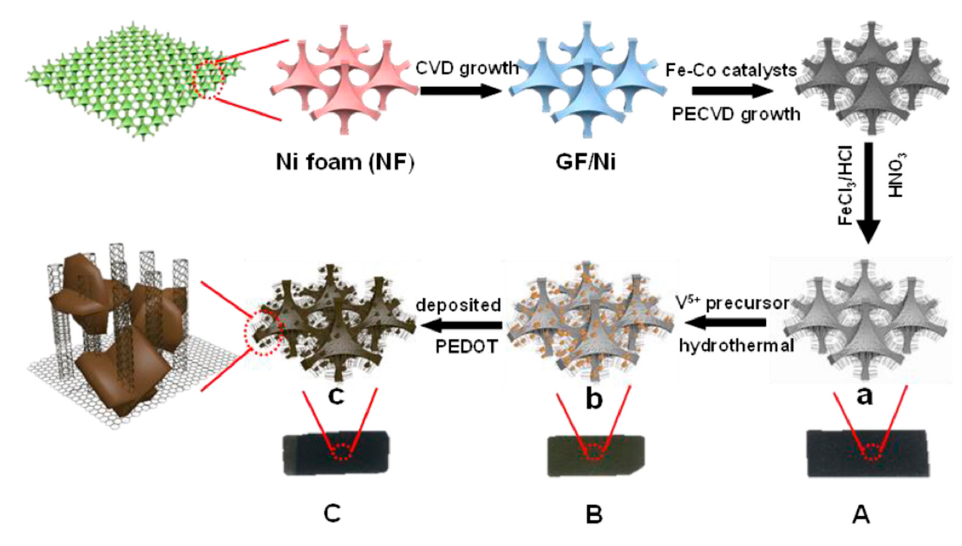
Figure 5. Schematic of the synthesis of ( A ) CNT/GF, ( B ) VCNT/GF, ( C ) VCNT/GF/PEDOT. Reprinted with permission from Ref. [88]. Copyright 2017 Royal Society of